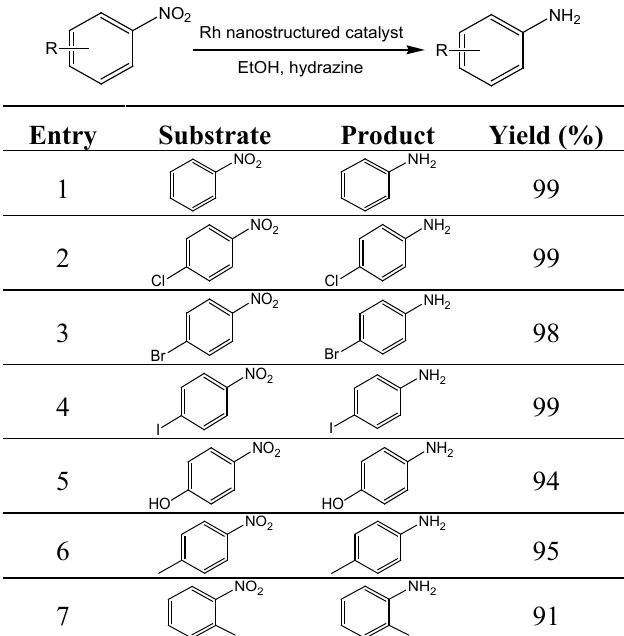
Table 4. Heterogeneous reduction of nitrobenzene derivatives with hydrazine. Reprinted with permission from [63]. NO 2 R Entry Substrate Product Yield